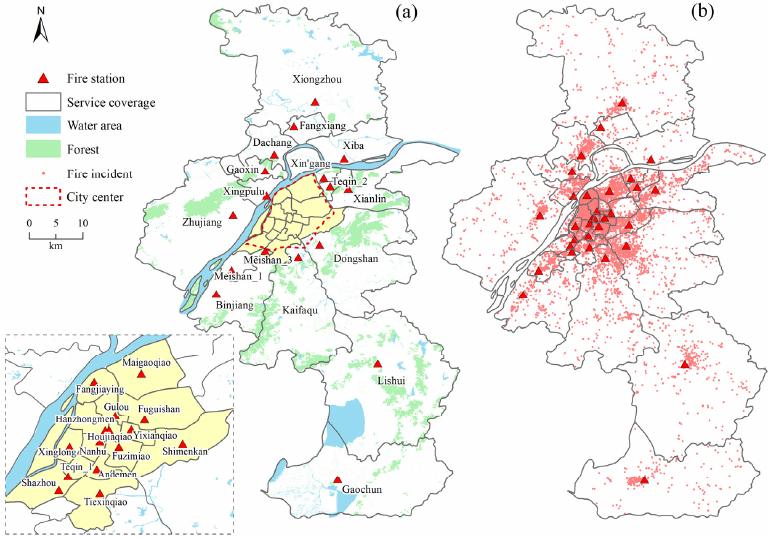
Figure 1. The spatial distribution of (a) the service coverage of fire stations and (b) historical fire incidents in Nanjing, China.